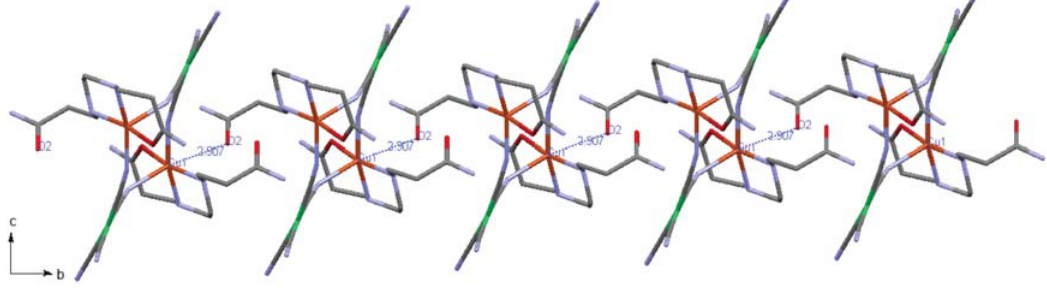
Fig. 3. The contacts between copper ion and the amide oxygen of dangling arm in adjacent tetranuclear species in complex 1 .